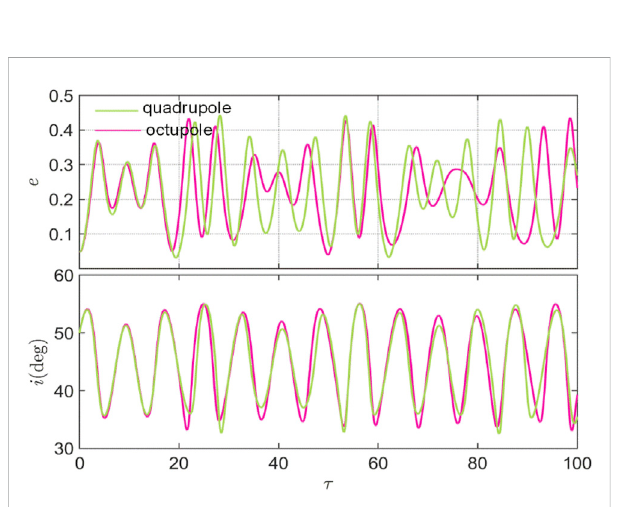
FIGURE 11 Eccentricity and inclination evolution over 100 scaled time for ε (cid:2) 0 . 01 by using the quadrupole-level and octupole-level models. Oct The initial orbital elements are e 0 (cid:2) 0 . 05, i 0 (cid:2) 50 ° , Ω 0 (cid:2) 60 ° and ω (cid:2) 0. The perturbing body ’ sorbit is assumed to be fi xed at ω 0 (cid:2) 0 ° . Ω B